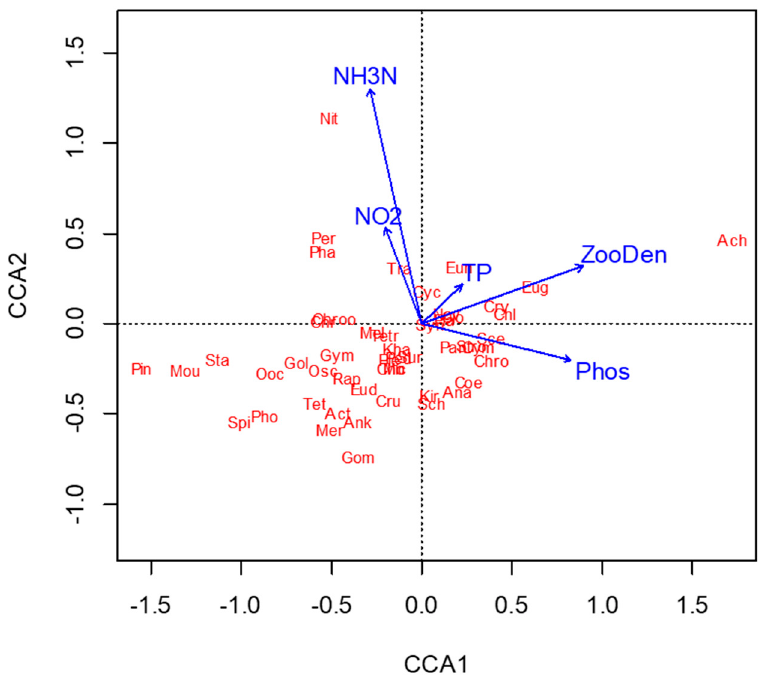
Figure 3. CCA ordination diagram of the environmental variables (TN, TP, NH 4+ , NO 3 − , NO 2 − , PO 43 − , COD Mn ), zooplankton density (ZooDen), and phytoplankton community (see Table S3 for details of the phytoplankton taxa).